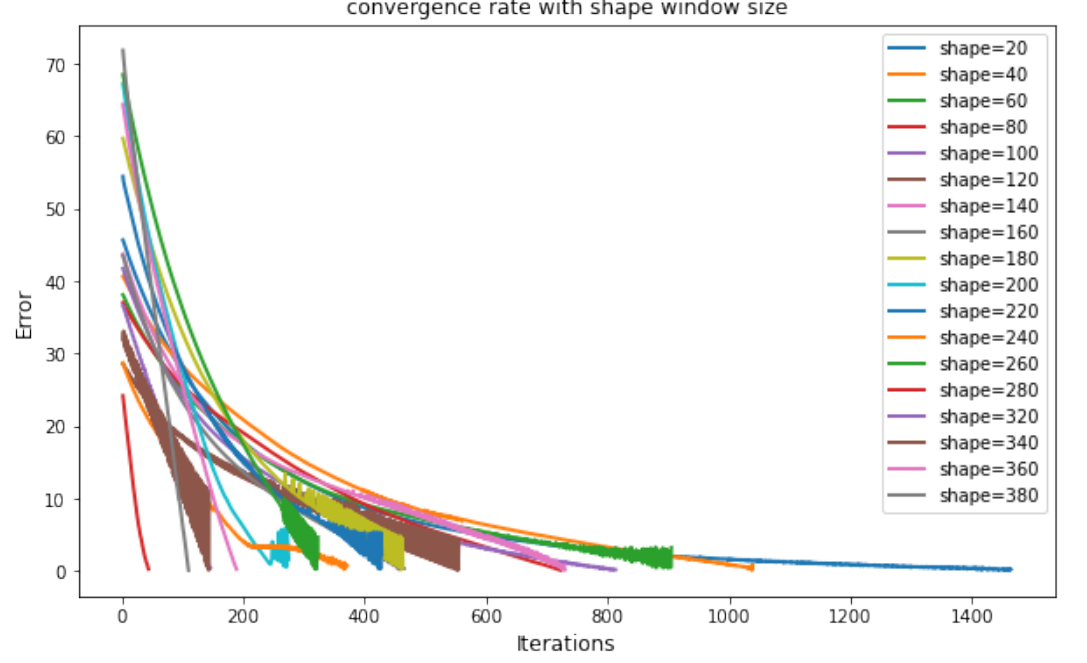
Figure 5. Disaggregation convergence rate with shape window size in the REDD